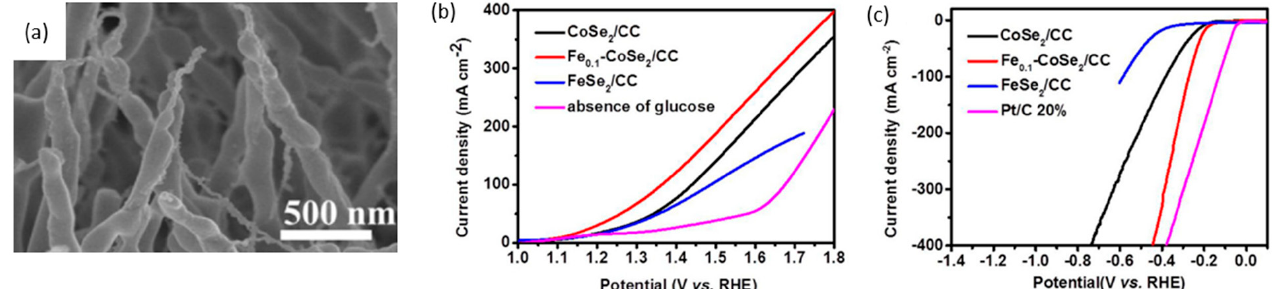
Figure 23. ( a ) SEM image of Fe 0.1 CoSe 2 /CC. ( b ) LSV for anodic glucose oxidation, 1 M KOH, 0.5 M glucose with different electrodes. ( c ) LSV for cathodic hydrogen evolution, 0.5 M H 2 SO 4 . Reprinted with permission from Ref. [115]. Copyright 2020, Applied Catalysts B: Environmental.